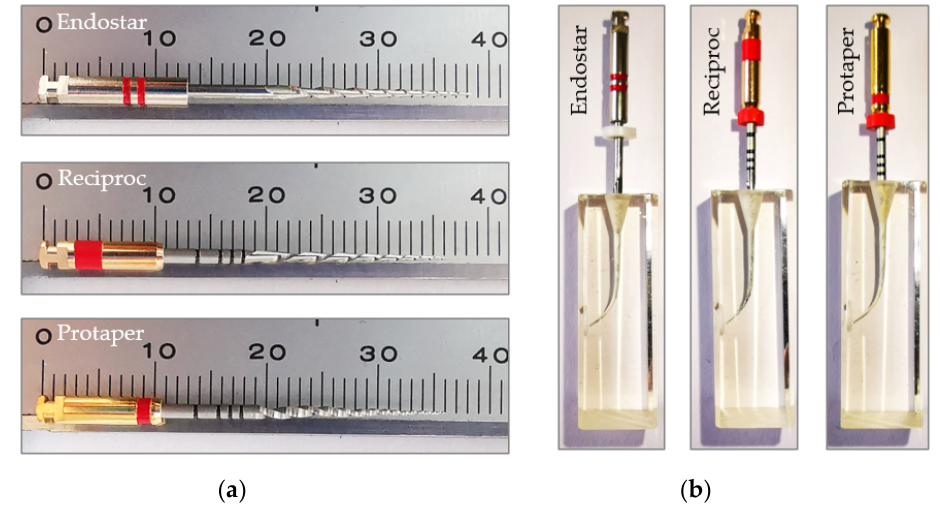
Figure 1. The three investigated types of NiTi rotary instruments before torsional fracture: ( a ) measurements of their dimensions; ( b ) instruments introduced in the simulated root canals. Notations: Endostar, Reciproc, and Protaper stand for the three considered groups.